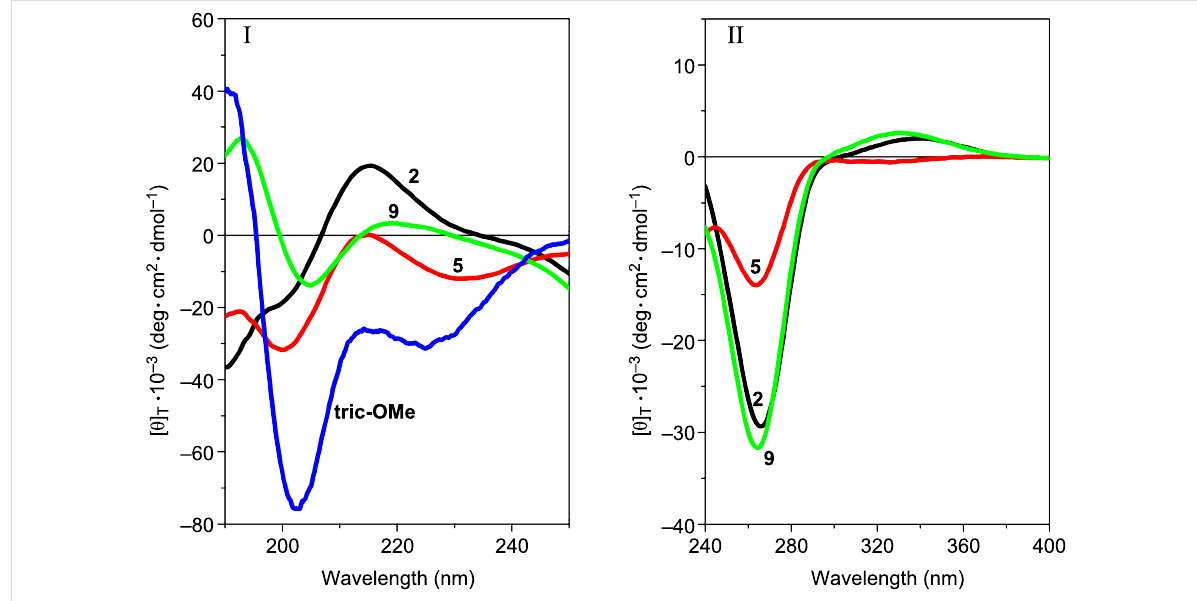
Figure 3: Far-UV (panel I) and near-UV (panel II) CD spectra of [Leu 11 -OMe] trichogin GA IV ( tric-OMe ) and its ψ [CS-NH] 2 ( 2 ), ψ [CS-NH] 5 ( 5 ), and ψ [CS-NH] 9 ( 9 ) analogues in TFE solution. Peptide concentration: 1 mM.